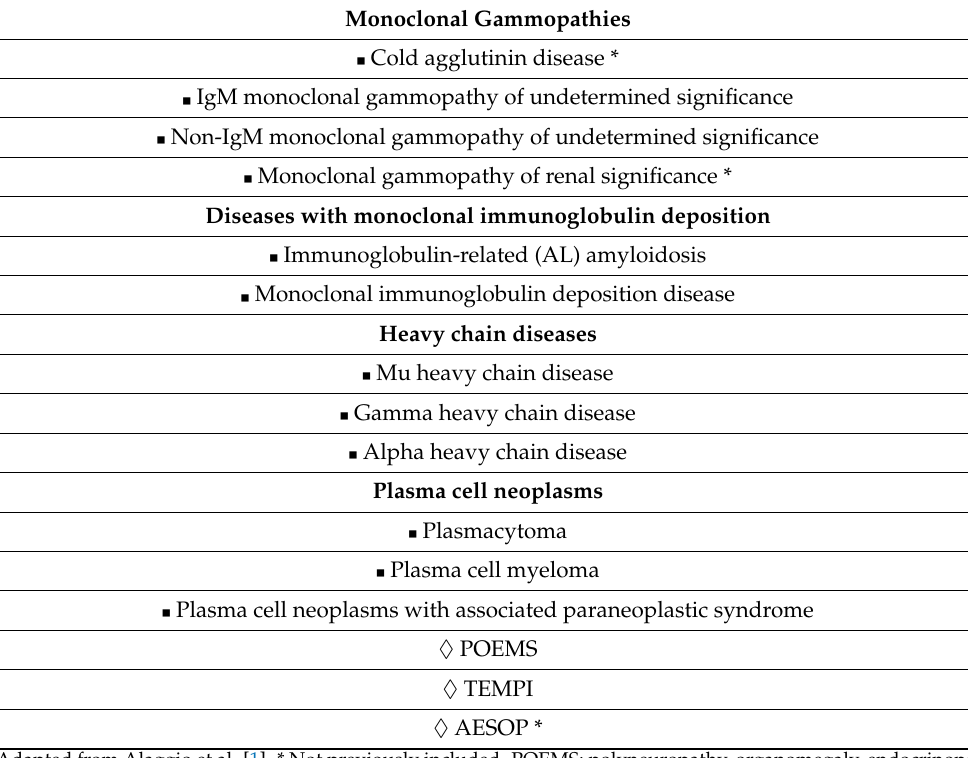
Table 2. International Consensus Classification of Mature B-cell Neoplasms. IgM Monoclonal Gammopathy of Undetermined Significance (MGUS)